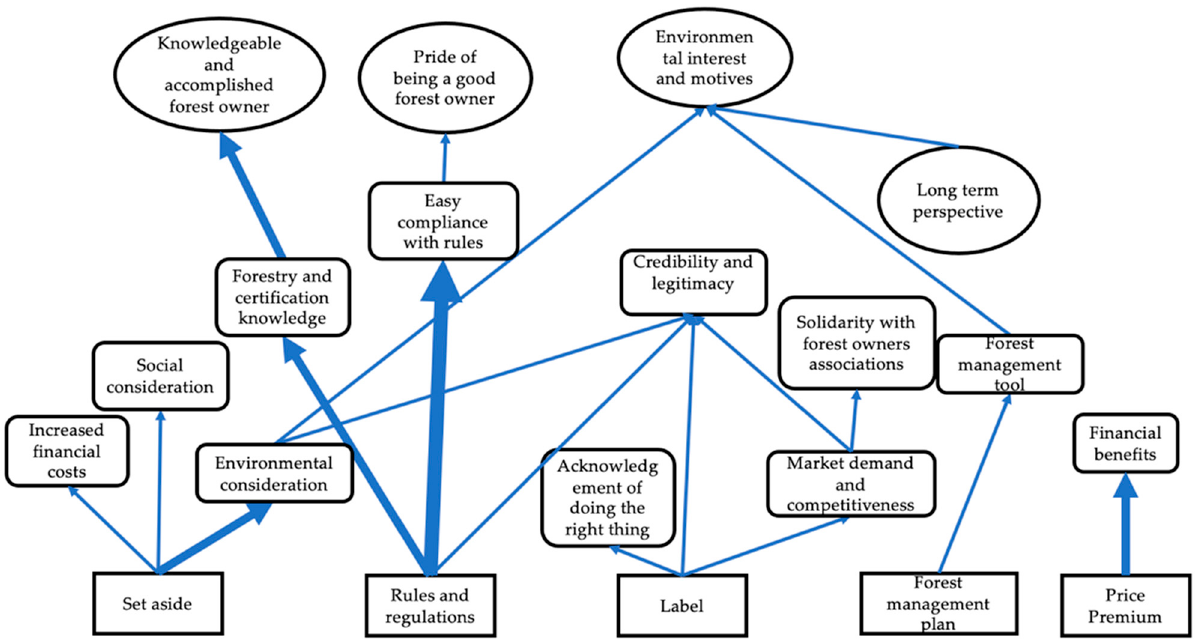
Figure 5. Respondents with other occupations and income than from forestry management (N = 8).